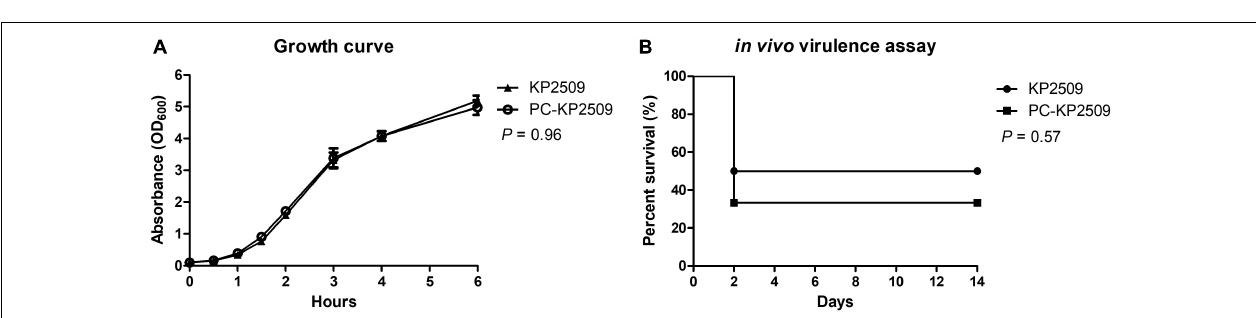
FIGURE 4 | (A) The growth curves of KP2509 and PC-KP2509 strains were observed during 0–6 h, respectively, and the tendency of KP2509 was similar that of PC-KP2509 ( P = 0.96). Each value was performed from the three independent experiments, and the statistical difference was analyzed by Mann–Whitney U test. (B) KP2509 and PC-KP2509 strains with 2.1 × 10 6 cfu were intraperitoneal inoculated into mice, and survival rates were compared during 2 weeks. No statistical difference in Kaplan–Meier analysis with a log-rank test ( P =